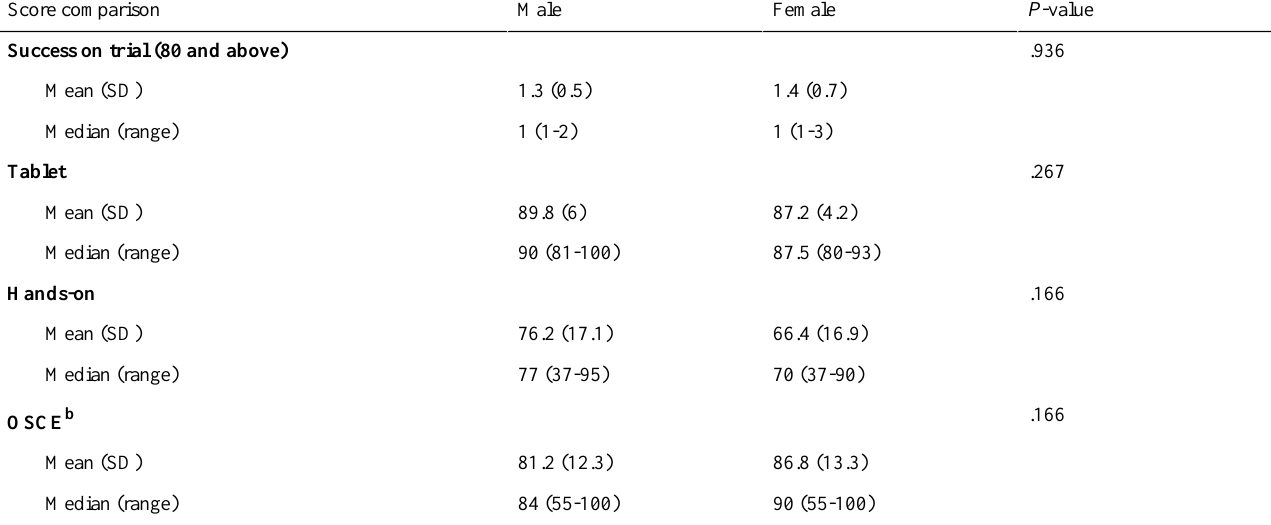
Table 3. Comparisons according to gender a